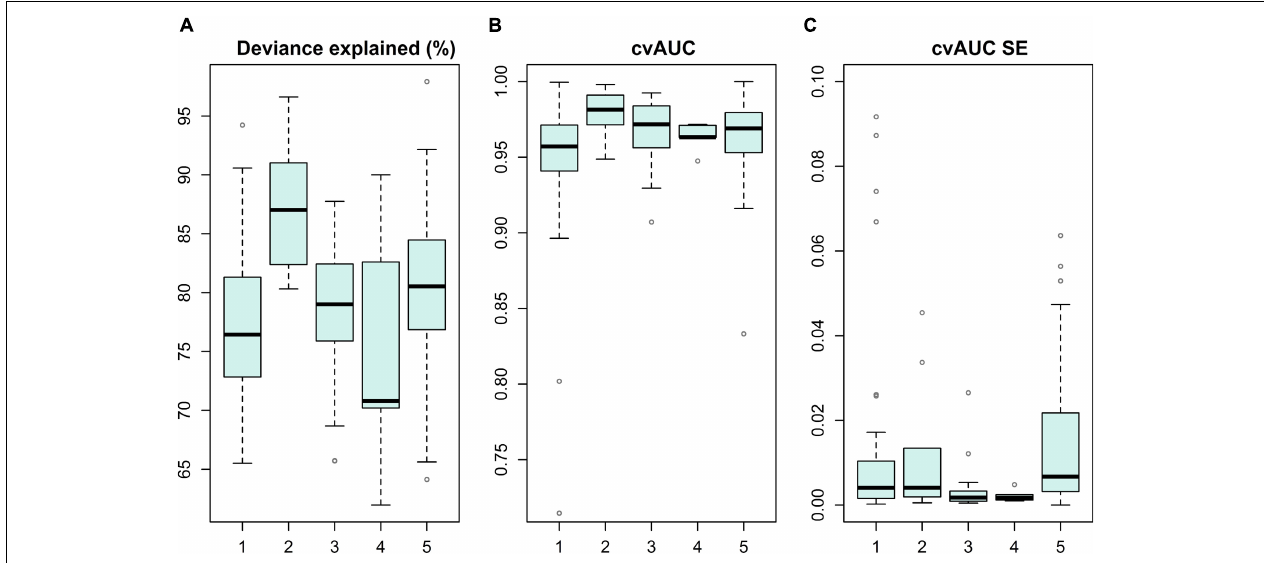
FIGURE 3 | Statistical distribution models and their performance reported as deviance explained (%) (A) , cross-validated AUC value (B) , and standard error for AUC on withheld test data (C) . Models are grouped into categories of (1) macroalgae, (2) bryophytes, (3) IUCN Red List of Ecosystems, (4) benthic invertebrates and (5) vascular